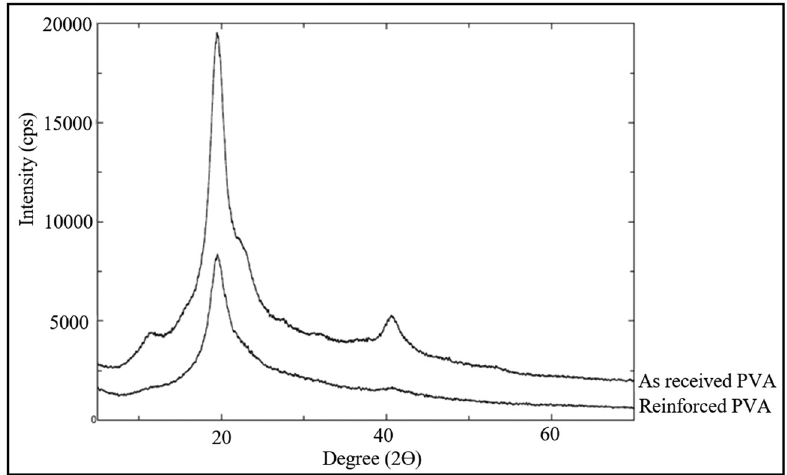
Figure 12: XRD of as - received PVA and reinforced PVA